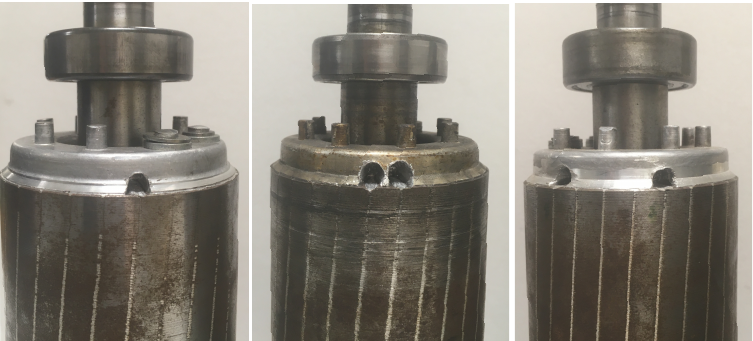
Figure 11. Tested rotors with faulty cages: one broken bar ( left ), two consecutive broken bars ( centre ) and two non-consecutive broken bars ( right ).